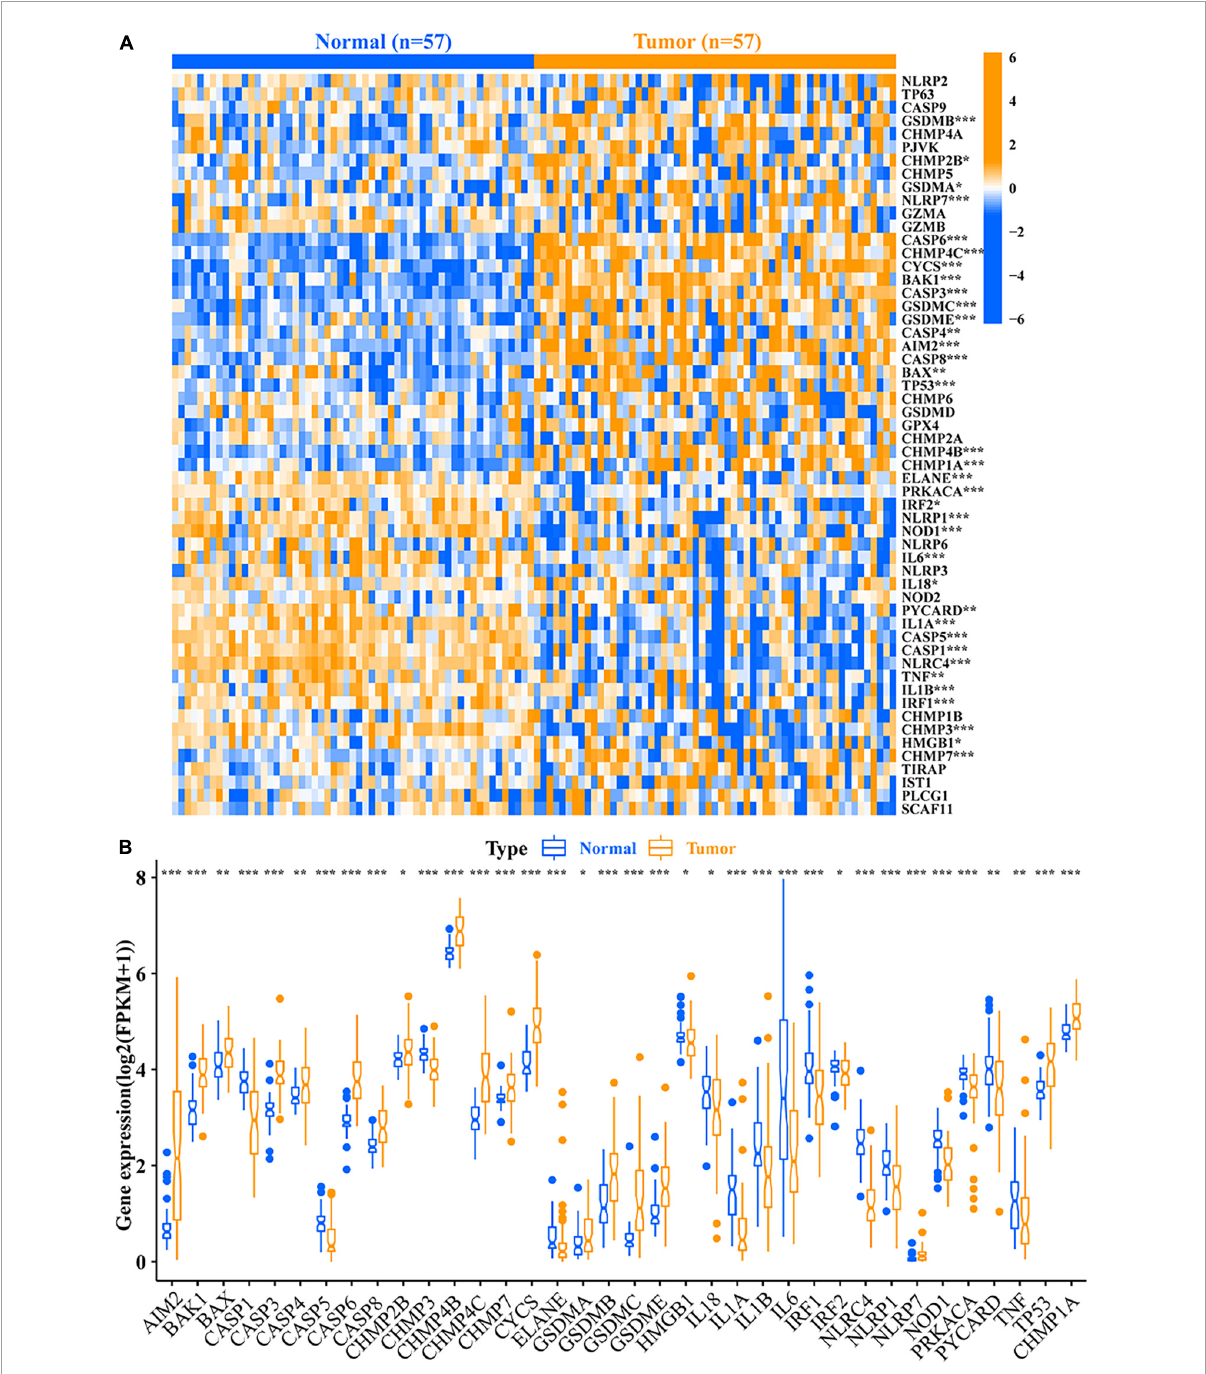
FIGURE2 Relative expression level of 56 PRMs. (A) Heat map of the PRMs between the normal tissues and the tumor tissues. (B) Expression level of 36 DEPRMs in the normal and tumor tissues. * p -value < 0.05; ** p -value < 0.01; and *** p -value < 0.001. PRMs, pyroptosis-related mRNAs; DEPRMs, differentially expressed pyroptosis-related